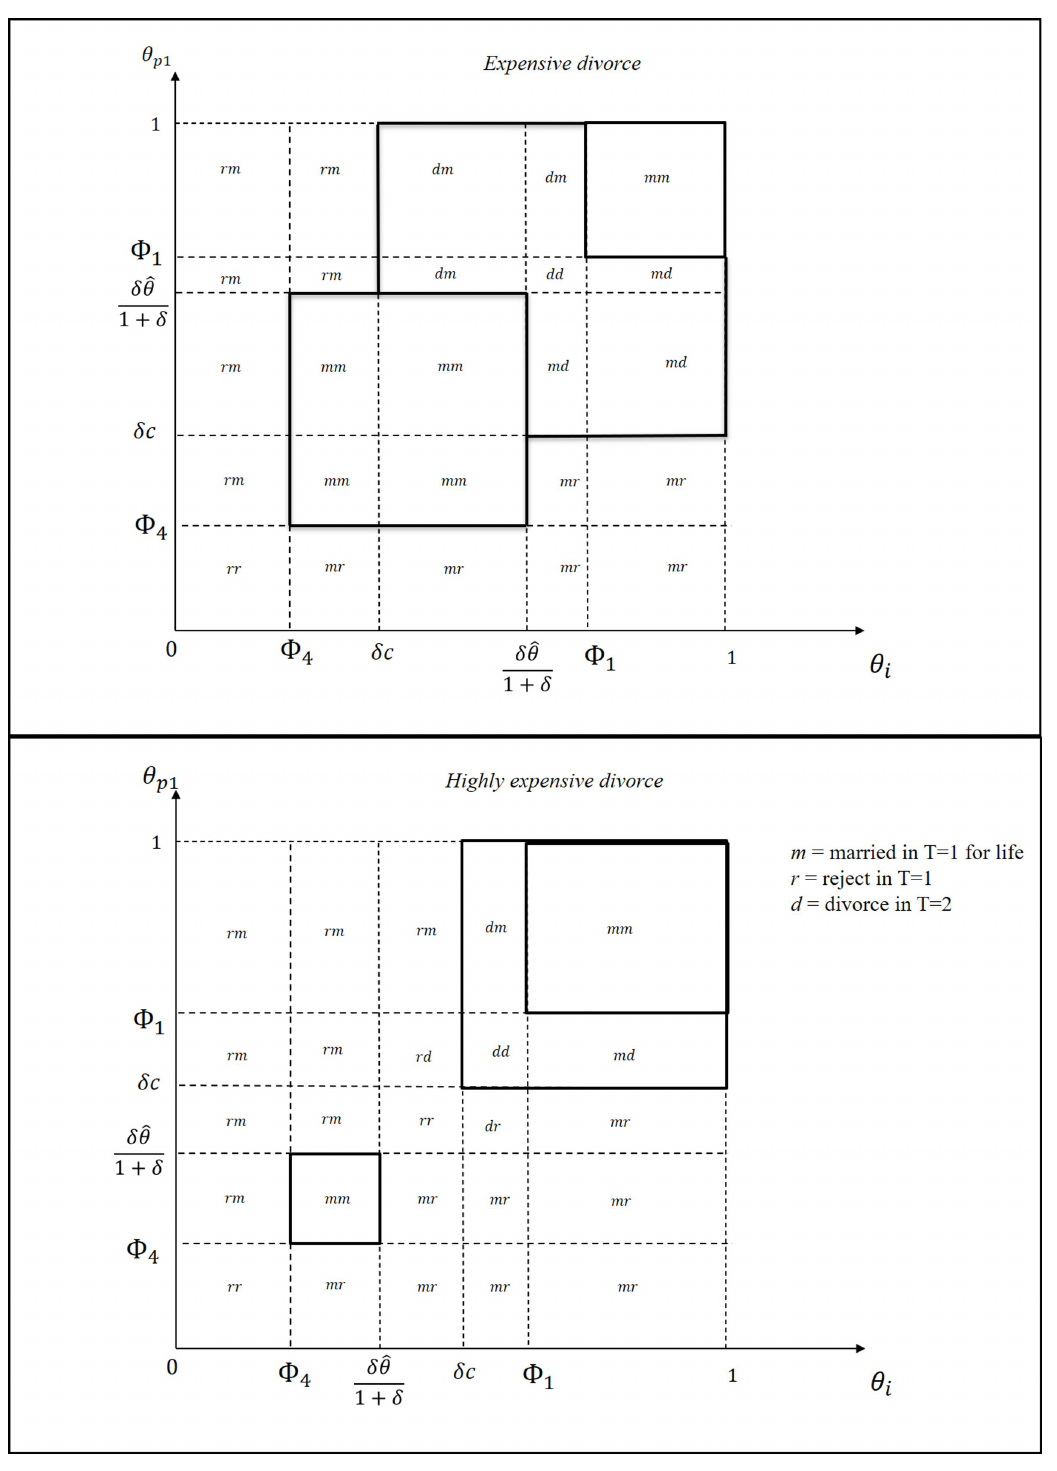
Figure 4. Equilibrium configurations where the divorce option condition does not hold for some